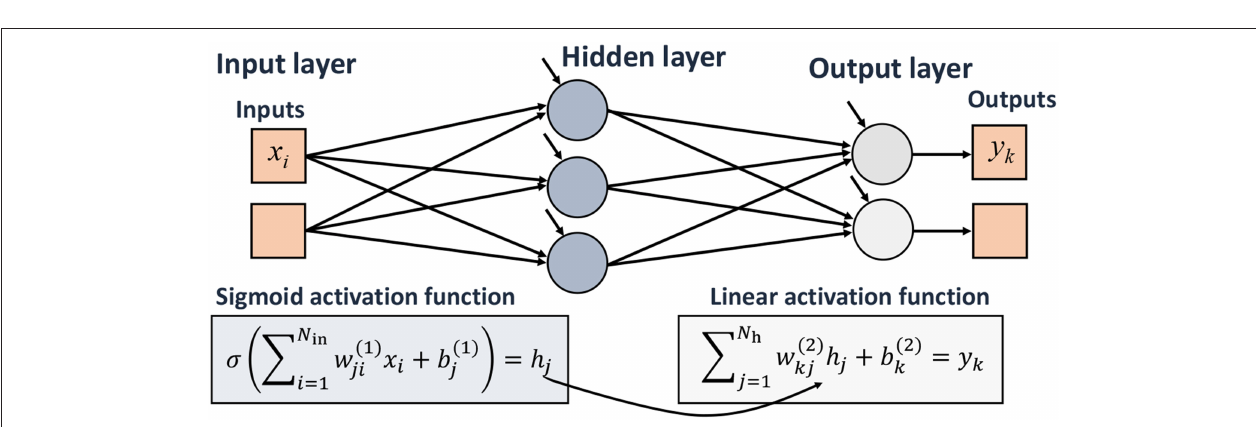
FIGURE 2 | Schematic of a single-hidden-layer neural